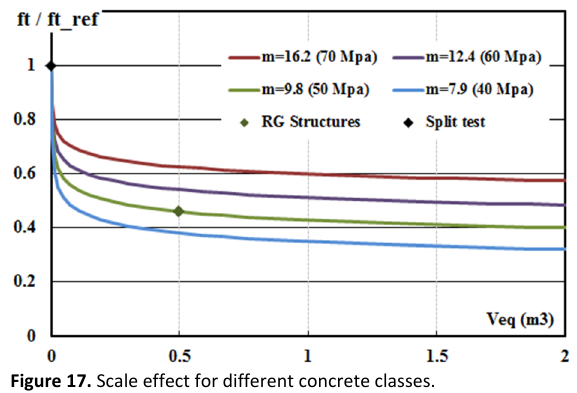
Figure 17. Scale effect for different concrete classes.